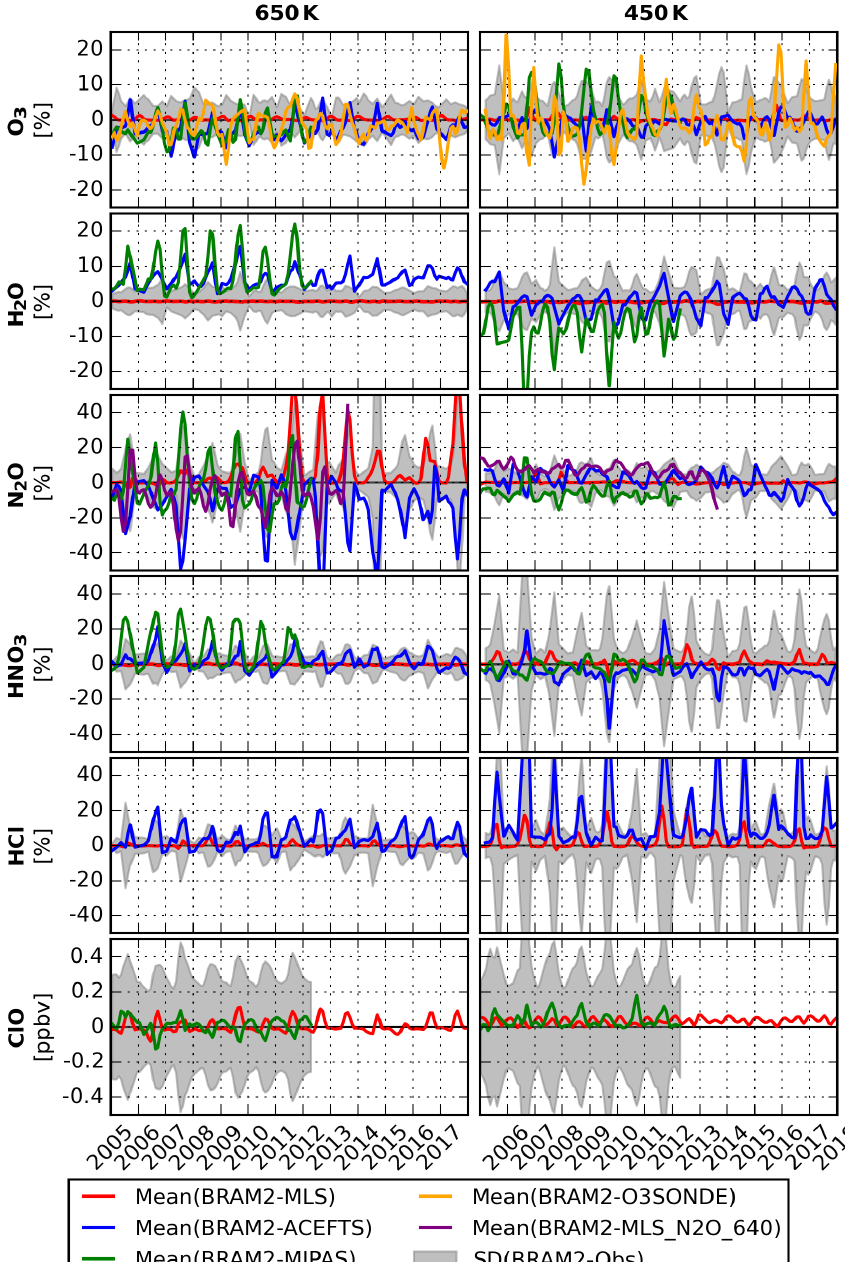
Figure 8. Time series of the monthly mean differences between BRAM2 and the different observational datasets between 90 and 75 ◦ S of equivalent latitude at two potential temperature levels (from left to right: 650 and 450K) and for (top to bottom) O 3 , H 2 O, N 2 O, HNO 3 , HCl and daytime ClO. Values are in percent except for ClO, which is shown in parts per billion by volume. The grey shaded area represents the standard deviation of the differences between BRAM2 and ACE-FTS except for ClO where MIPAS data are